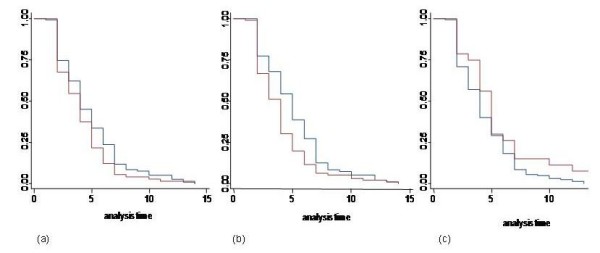
Kaplan-Meier survivor function plots for cessation of sheddding of RSV in infected Kenyan children. Results are categorised by age class (blue: 0-23 months; maroon: 24+ months) in Graph a, by infection history (blue: never infected; maroon: infected-significantly different; log rank test p < 0.05 ) in Graph b, and by severity (blue: URTI; maroon: LRTI) in Graph c.